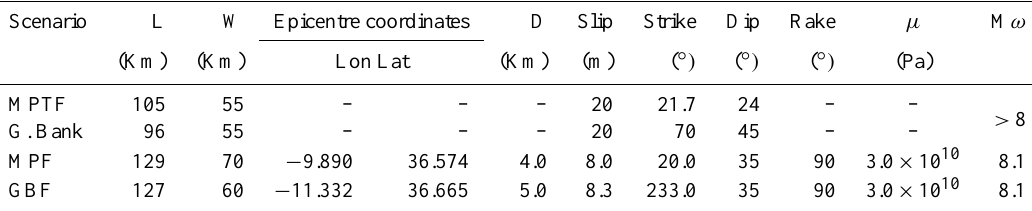
Fig. 2. Source (a) : considered the most destructive simulated, Baptista et al. (2003). Source (b) : MPF event, considered the moderated case, Omira et al. (2009). Source (c) : GBF event, considered the weakest, Omira et al. (2009). Table 1. The considered scenarios, the fault for each scenario, the length and the width of the faults, depth from the sea bottom to the top of the fault and the moment